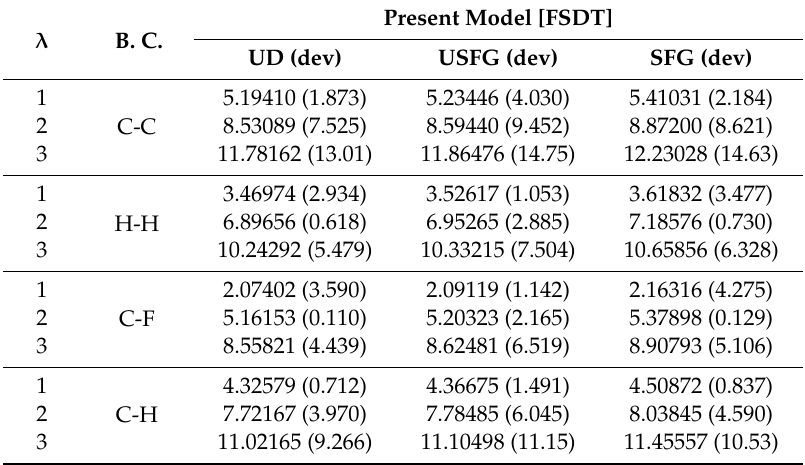
Table 6. Natural frequencies in order of the material distribution and boundary conditions. Present model with Q9 element.